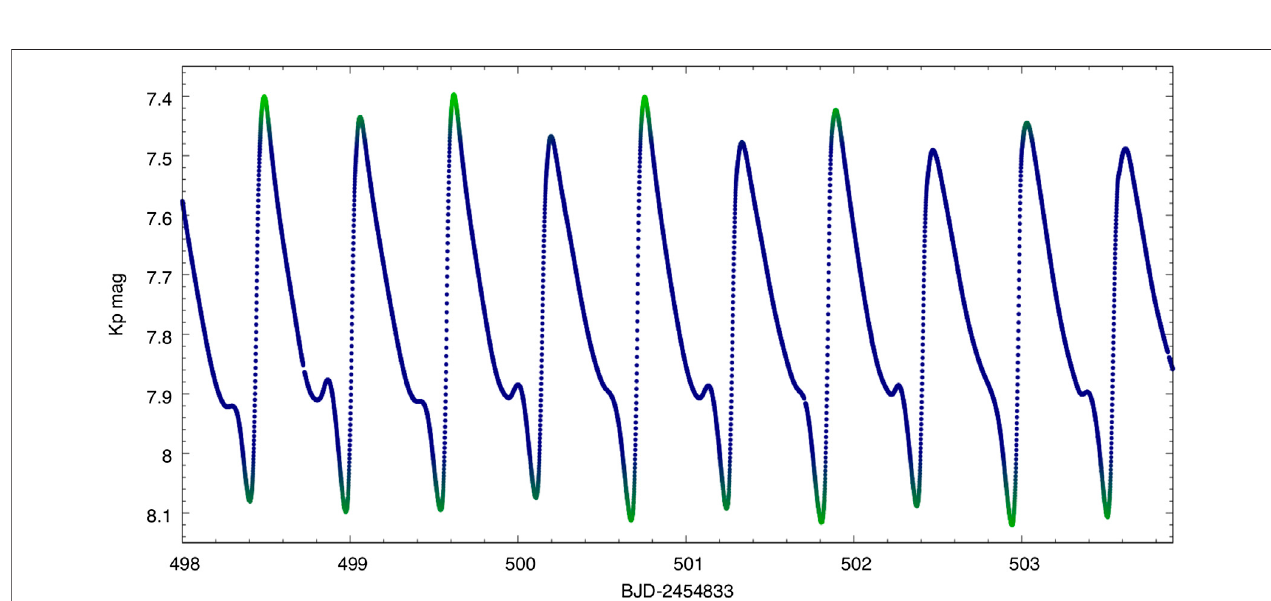
FIGURE2| AlternationofthepulsationamplitudesofRRLyr,thebrightestrepresentativeofitsclass,asobservedby Kepler .Theobserved fl uxesweretransformed to K p magnitude, which is Kepler ’ s photometric system. Colors change with brightness for better visibility of the alternation. Data downloaded from the MAST.